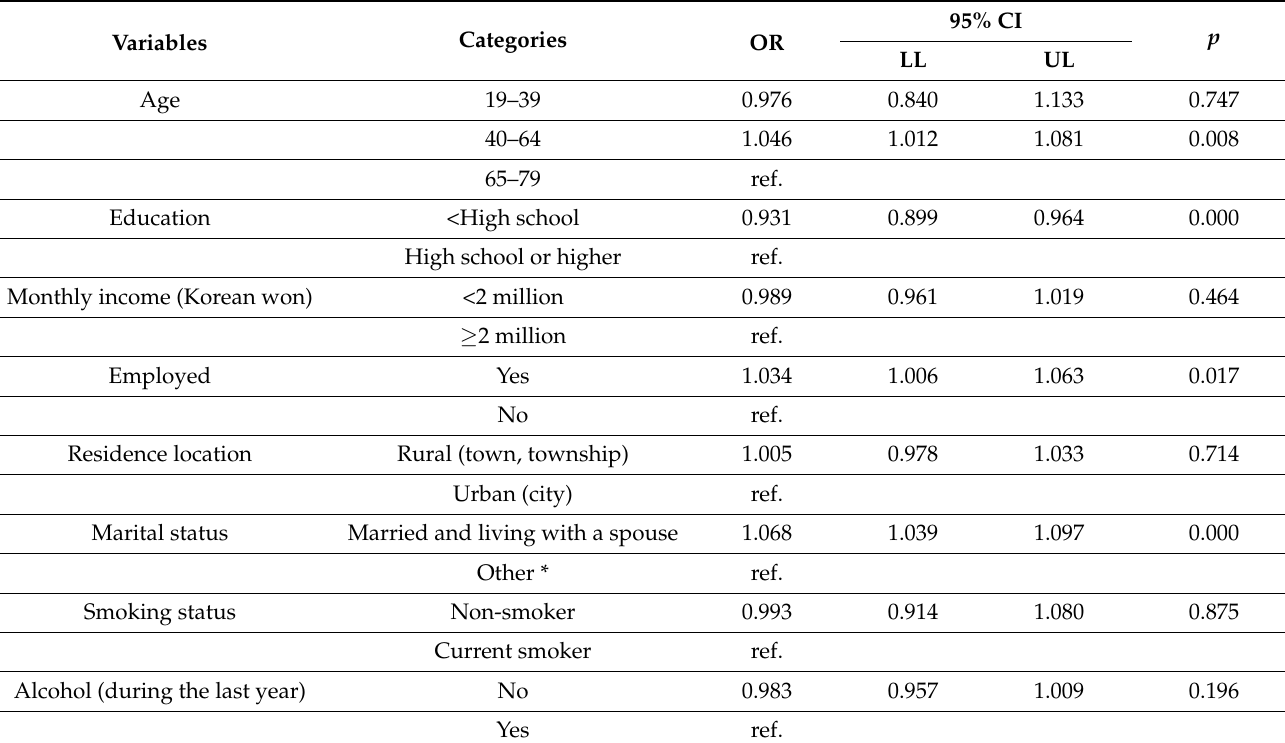
Table 3. Factors associated with knowledge of the cardio-cerebrovascular disease.